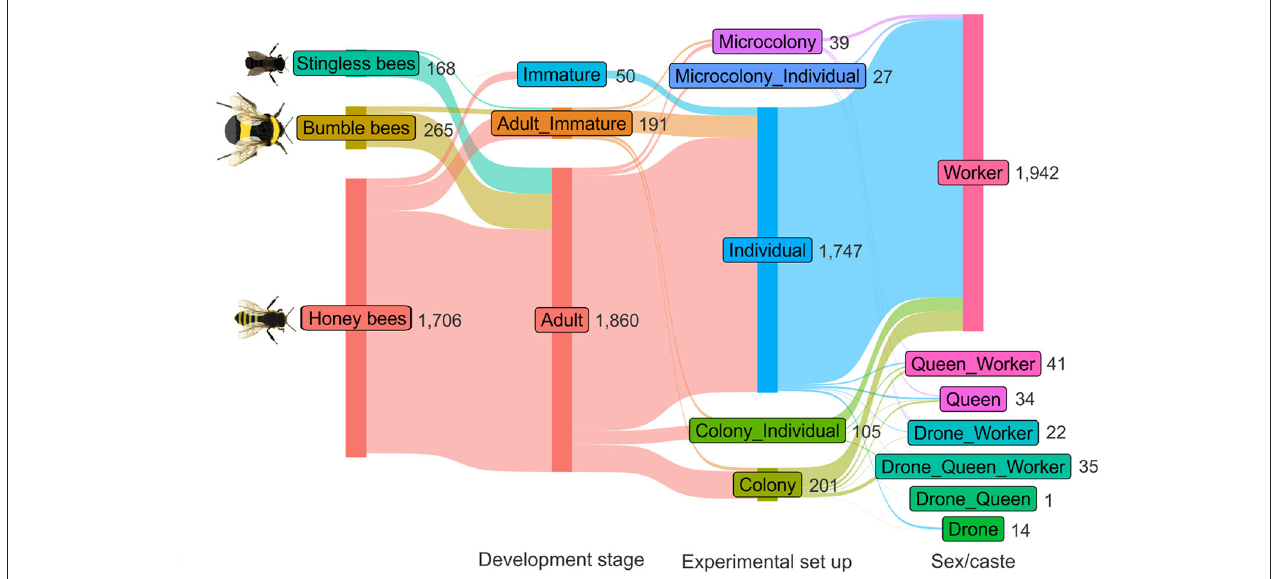
FIGURE 5 | Interaction flows among the development stages, experimental set ups (the level of social organization of the pollinators in which the study was performed), and sex/castes that were assessed in the main groups of bees found in the literature review ( n = 2,139) of toxicological assessment of the impact of agrochemicals on insect pollinators. The values on the right side of each node indicate the number of trials. The thickness of the nodes (rectangles) and arcs (links going from one node to another) is proportional to the frequency of interactions. Terms separated by a dash indicates that both terms were assessed. Microcolony: a queenless colony, initially established with few newly emerged